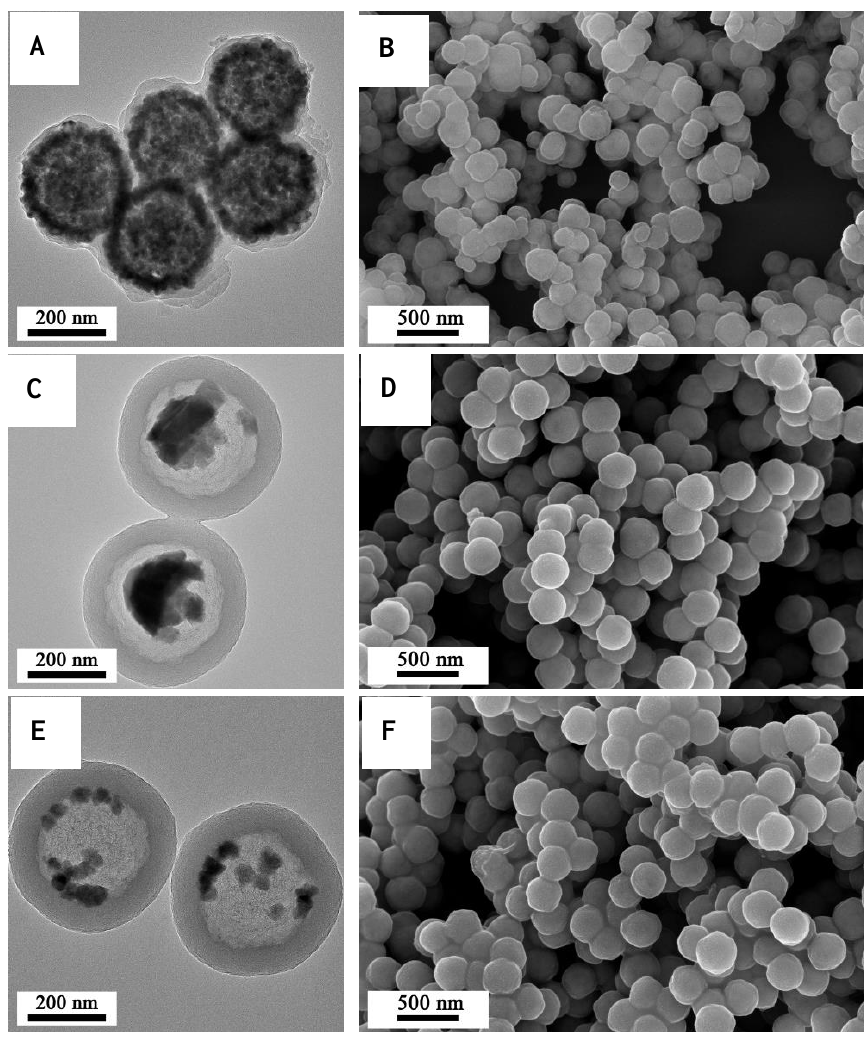
Figure 4. TEM ( A , C , E ) and SEM ( B , D , F ) images of carbonization products of Fe 3 O 4 @RF microspheres with different shell thicknesses: Fe 3 O 4 @C-6, Fe@C-10 and Fe@C-12.